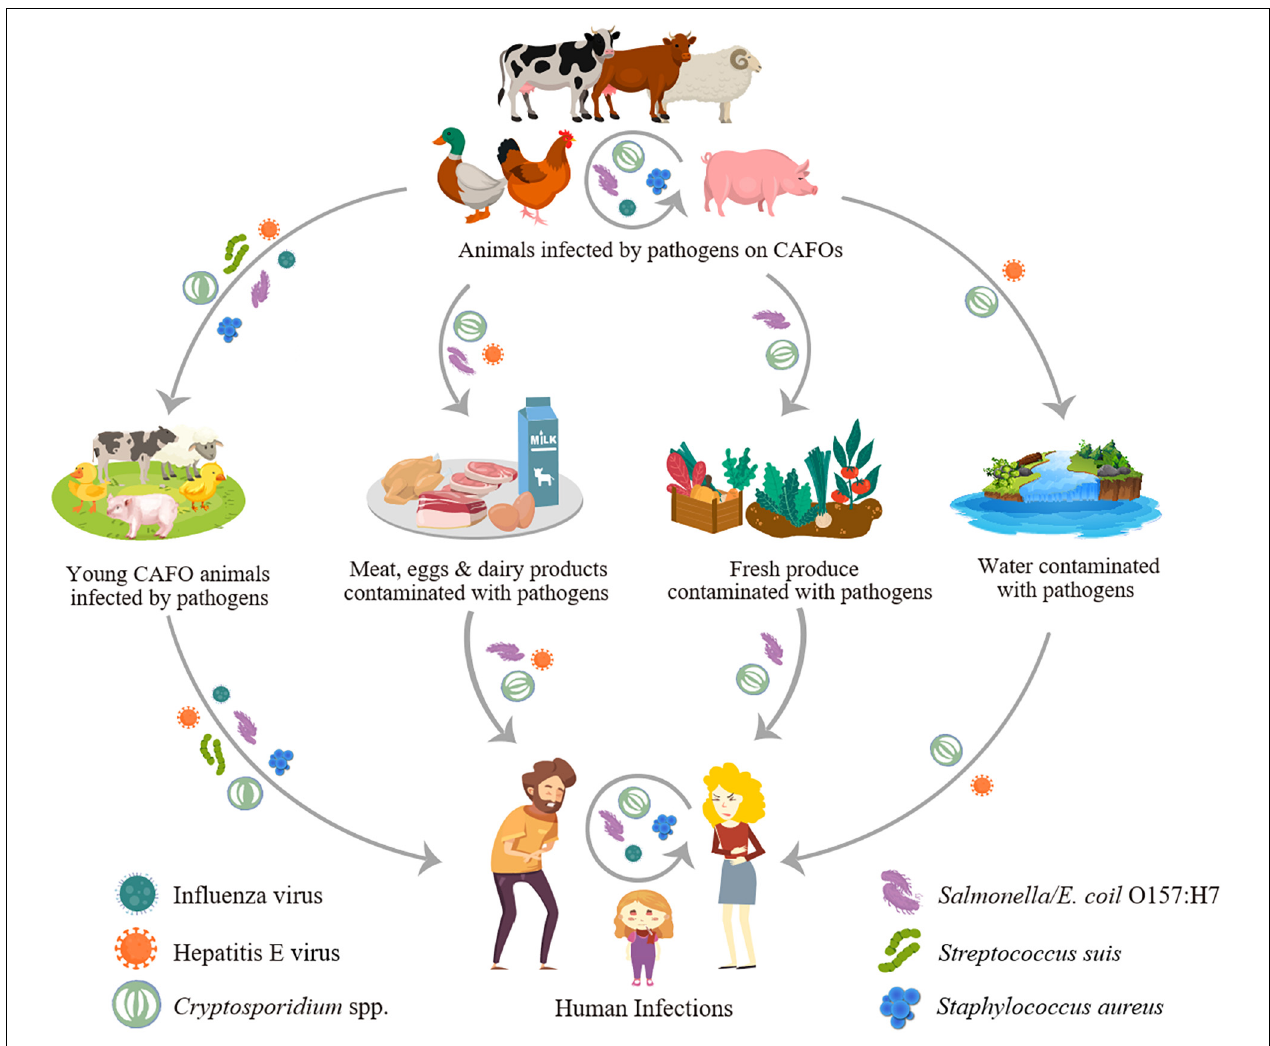
FIGURE 1 | Transmission of major zoonotic pathogens through concentrated animal feeding operations (CAFOs).